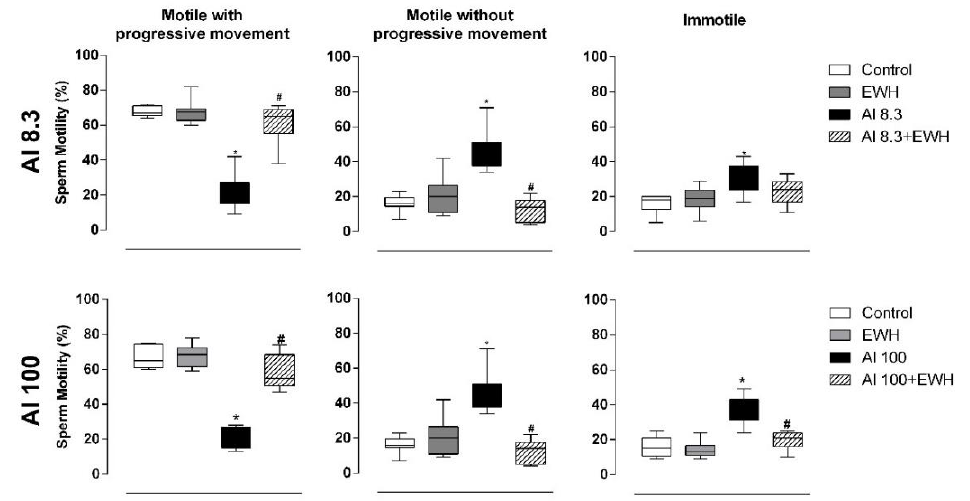
Figure 1. Effect of EWH on sperm motility of rats exposed to AlCl 3 at 8.3 or 100 mg/kg b.w. per day. The motility is classified as: motile with progressive movement, motile without progressive movement and immotile. Data are expressed as median (Q1–Q3), n = 8, * p < 0.05 compared with their corresponding controls, # p < 0.05 compared with AlCl 3 group (Kruskal–Wallis followed by Dunn’s